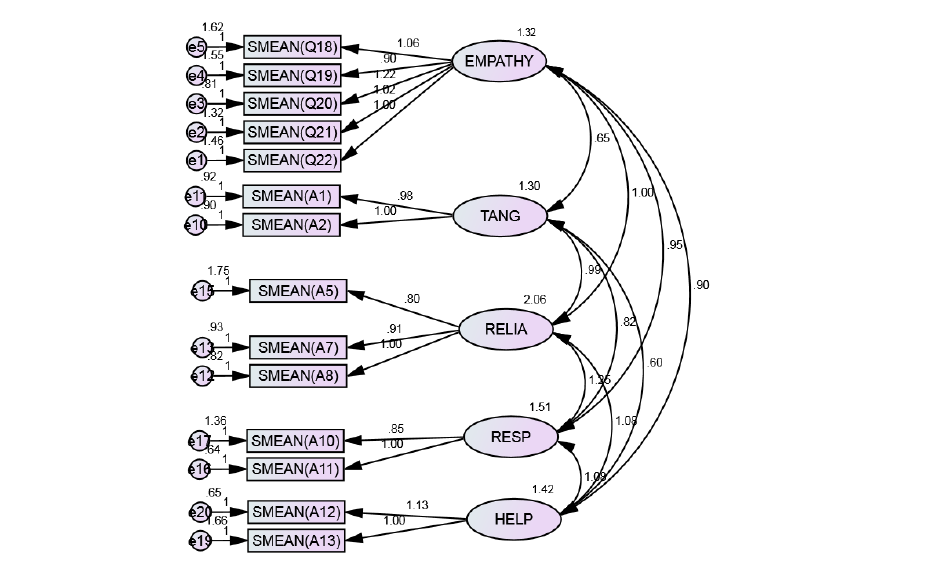
Figure 1. Measurement model for service